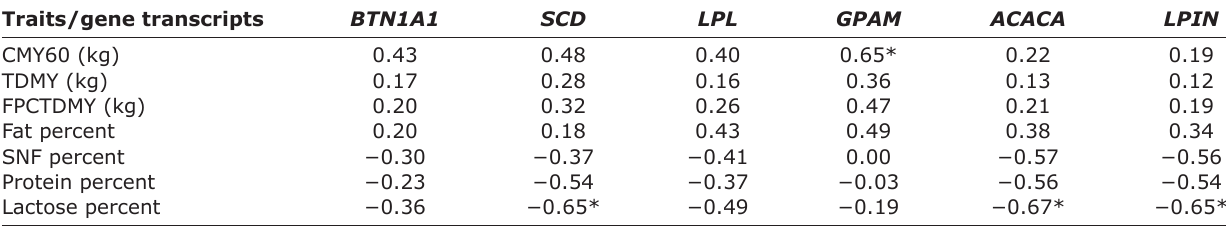
Table-8: Correlation coefficients among milk yield, composition and relative expression of major milk lipogenic genes in Jafarabadi buffaloes at day 60 pp. Traits/gene